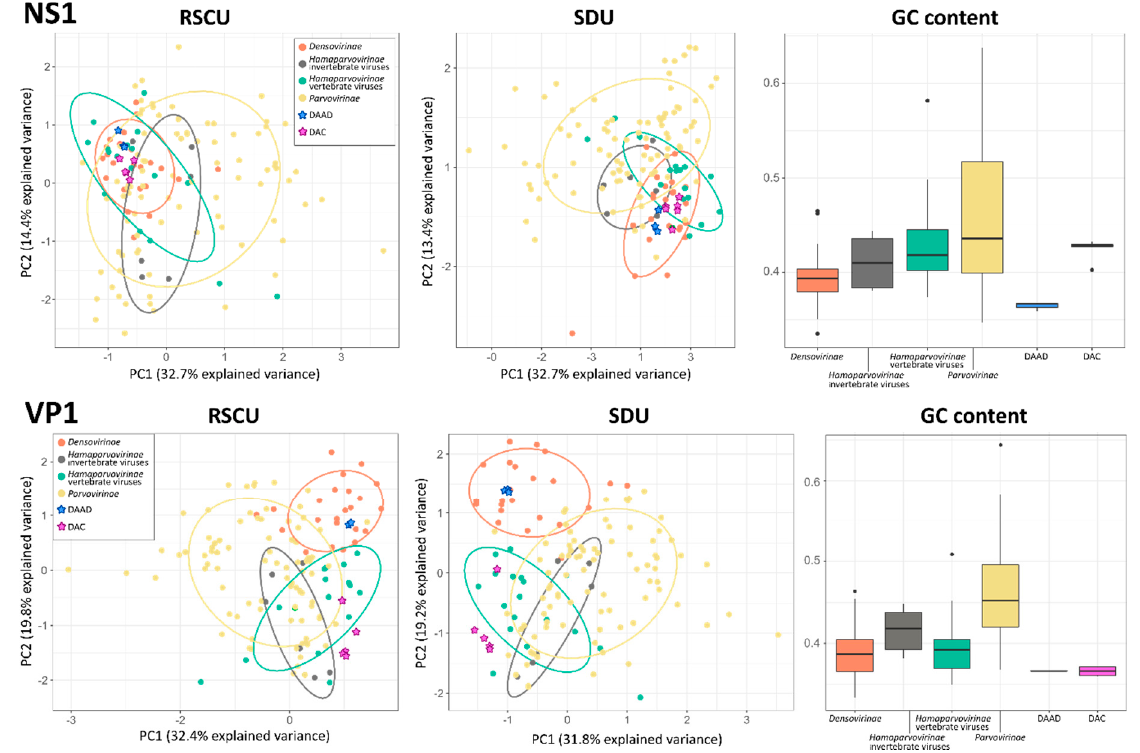
Figure 5. Compositional analyses of viruses within the Parvoviridae . Principal component analysis (PCA) plots based on relative synonymous codon usage (RSCU) and synonymous dinucleotide usage (SDU) values are shown on the left and in the center, respectively; ellipses are drawn around groups as indicated in the legend with a normal probability size of 70% and axes represent dimensions explaining the largest variances. Box-and-whisker plots based on GC contents in each group are showed on the right; upper and lower whiskers indicate the highest and lowest values within 1.5 times the interquartile range, while boxes indicate the interquartile range itself with average values displayed as thick lines. Dots indicate potential outliers.